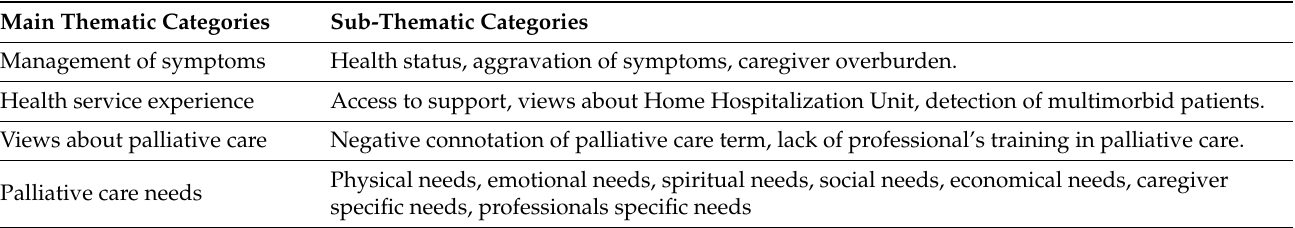
Table 1. Main and sub-thematic